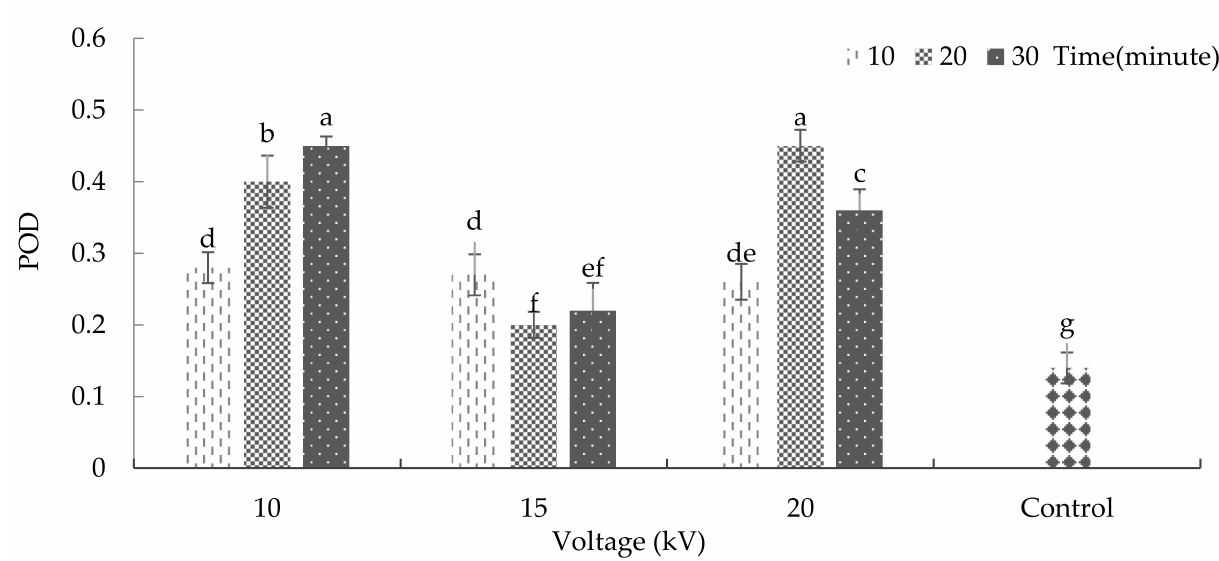
Figure 9. Plasma effect on peroxidase enzyme activity in basil. Error bars indicate standard error ( n = 3). Different lowercase letters denote statistical differences between treatment groups at the 5% level according to Duncan’s test.